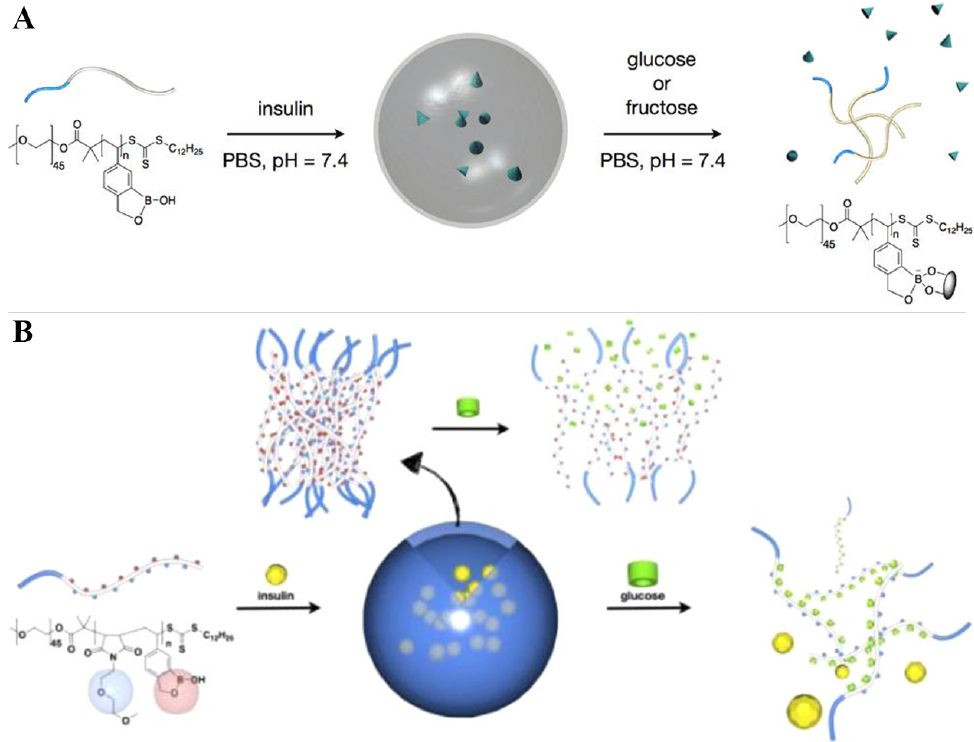
Figure 2: (A) Self-assembly of PEG-b-PBOx polymersome and its disassembly responding to monosaccharides. Reprinted with permission from [28]. Copyright 2012, American Chemical Society. (B) Schematic illustration for self-assembly and glucose-responsive disassembly of polymersomes. Reprinted with permission from [29]. Copyright 2012, American Chemical Society